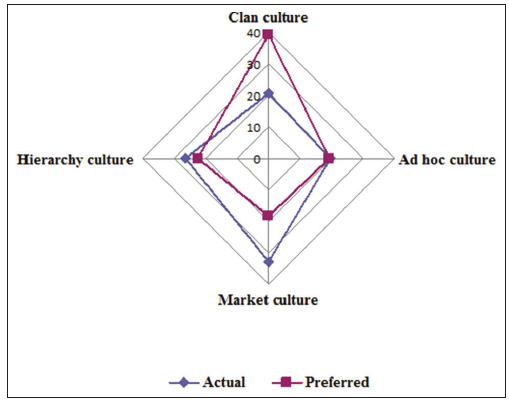
FIGURE 3. The actual and preferred organizational culture in PHC center B